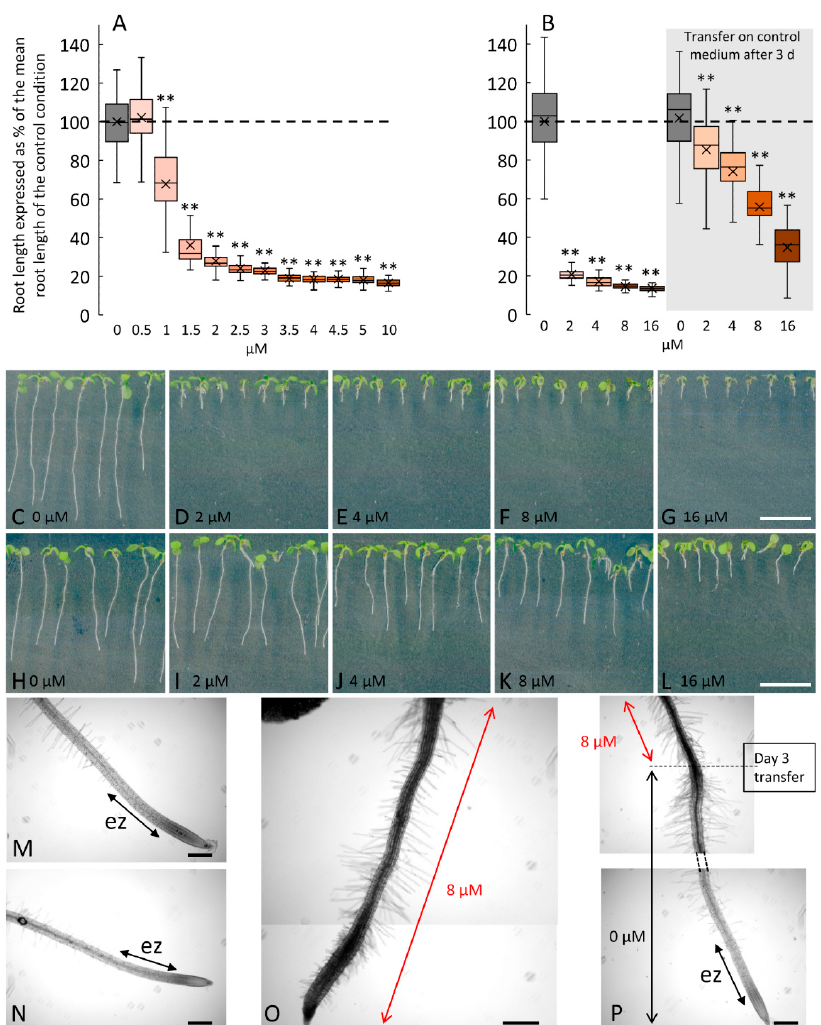
Figure 3. Dose response and reversible effects of 2F-Fuc on Arabidopsis root growth after 7 days on treated medium or cultivated for 3 days on treated medium and then transferred on the control medium. ( A ): Changes in root length of 7-day-old Arabidopsis cultivated in a medium supplemented with 0 to 10 µM of 2F-Fuc. ( B ): Effect of 2F-Fuc on the root length after 7 days on the treated medium (left panel) or after 3 days on the treated medium and 4 days on the control medium (right panel). ( C – I ): Representative pictures of Arabidopsis seedlings after 7 days on 0 to 16 µM of 2F-Fuc ( C – G ) or after 3 days on 0 to 16 µM of 2F-Fuc followed by 4 days on the control medium ( H – L ). M – P : Close-up pictures of 7-day-old roots in the control condition ( M , N ) or treated with 8 µM of 2F-Fuc ( O , P ) without or with transfer at day 3 on the control medium. Scale bars: ( C – L ): 10 mm; ( M – O ): 200 µm. ez, elongation zone. Dashed line in ( A , B ) represents the mean root length in control conditions. ** indicates statistically significant differences from the control condition ( p < 0.01). ( O ) is a reconstructed image made from two overlapping pictures.